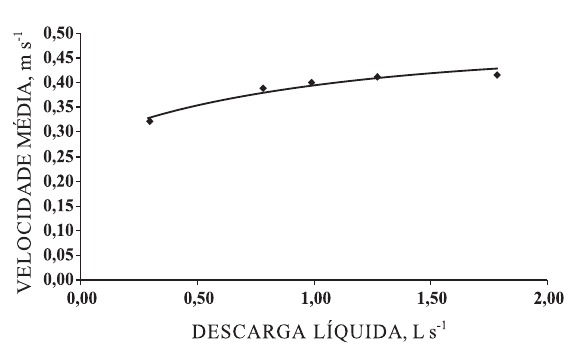
Figura 3. Relação entre a descarga líquida e a velocidade média da água nos sulcos formados em Cambissolo Háplico de textura média do semiárido Quadro 1. Geometria da seção transversal dos sulcos: área (A), perímetro molhado (P ) e raio m hidráulico (R ), em função das vazões aplicadas h nos sulcos em um Cambissolo Háplico textura média do semiárido brasileiro